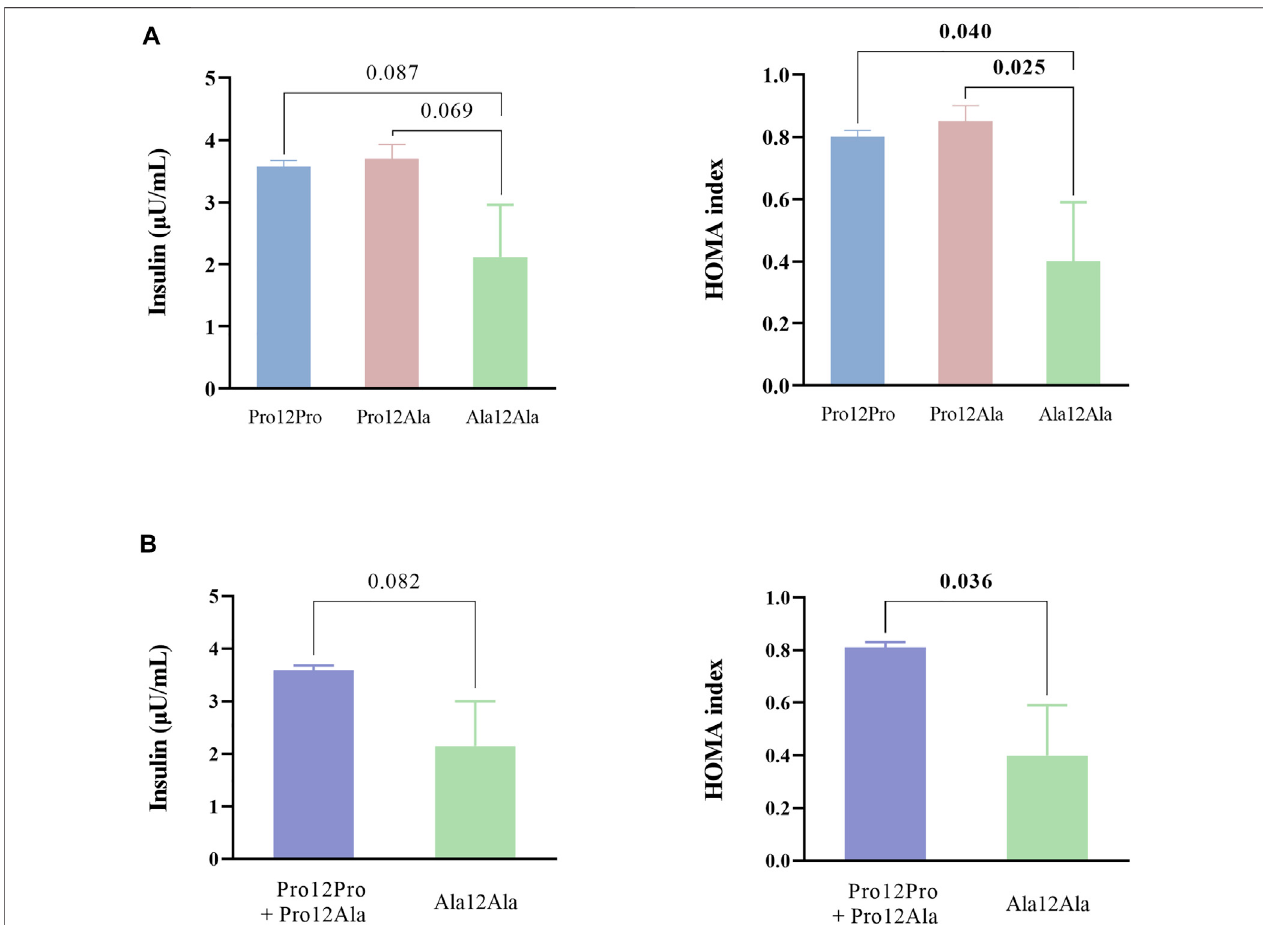
FIGURE1| InsulinlevelsandHOMAvaluesaccordingtothePPAR γ 2Pro12AlapolymorphismafteradjustingforBMIandleptinlevels. (A) Differencesbetweenthe three genotype groups tested using Kruskal – Wallis test. (B) Differences under a recessive model for the Ala allele tested using Mann-Whitney U test Data are presented as means with their standard errors. HOMA: homeostasis model assessment of insulin resistance.